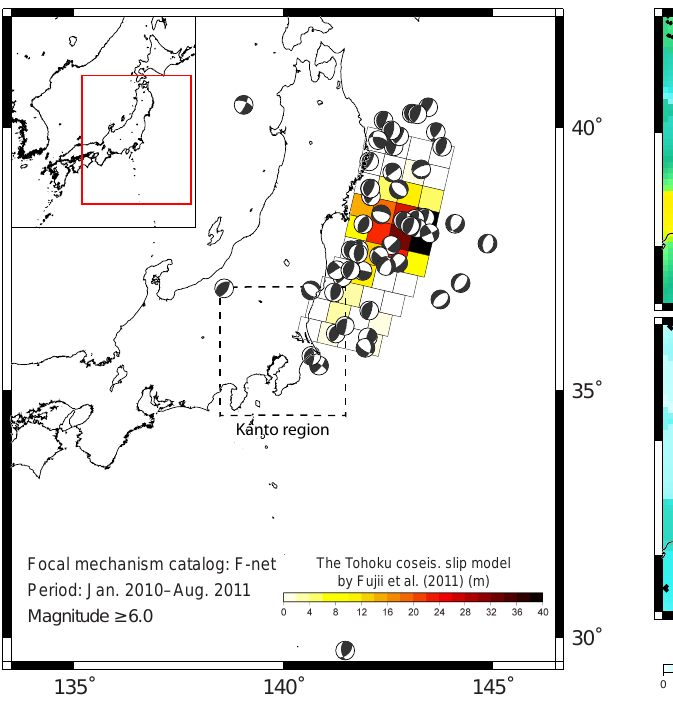
Figure 6. The two-dimensional forecasting models for the magni- tudes between (a) 4.0 and 4.9; (b) 5.0 and 5.9; (c) 6.0 and 6.9; and (d) 7.0 and 7.9, respectively, at the end of August 2011. Black dots denote the M ≥ 4.0 earthquakes during January 2010 and August